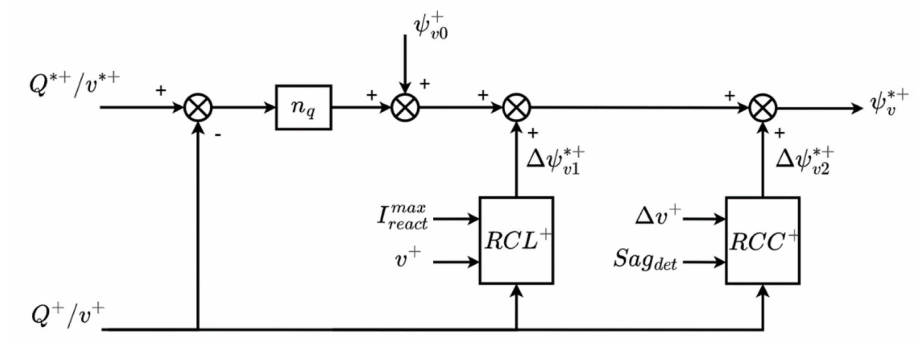
Figure 7. Positive reactive power controller block.